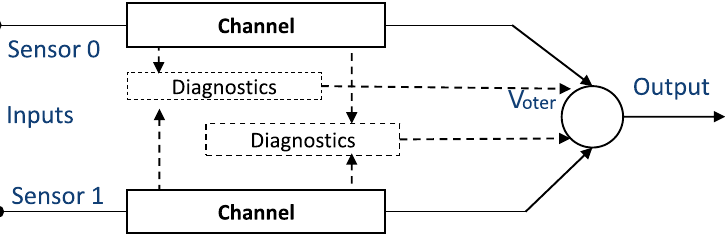
Figure 2. Model of the 1oo2D (1-out-of-2 with diagnostics) safety